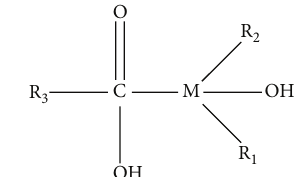
Figure 1: Molecular structure of SAV-1.